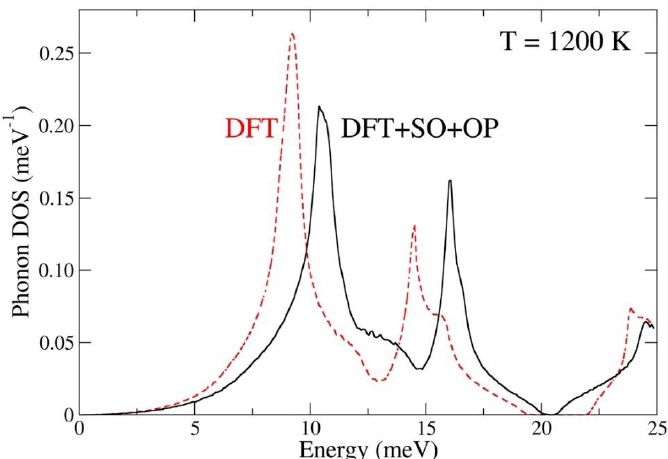
Figure 4. SCAILD phonon density of states (states/meV) at 1200 K from electronic structure that includes spin-orbit coupling and orbital polarization (DFT+SO+OP) and not (DFT). The atomic volumes are 15.6 Å 3 (DFT) and 16.2 Å 3 (DFT+SO+OP), respectively.